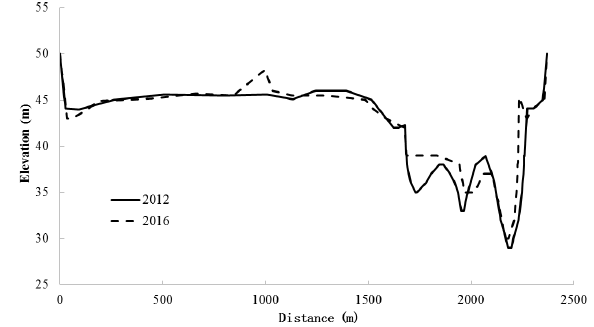
Figure 4. The cross section at the bridge in the Hanjiang